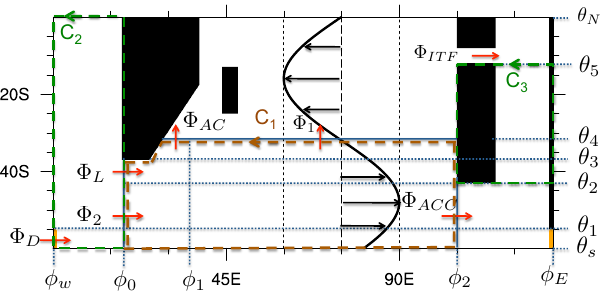
Fig. A1. Domain of computation with the main sections along which the transport is computed and the contours of integration C 1 , C 2 and C 3